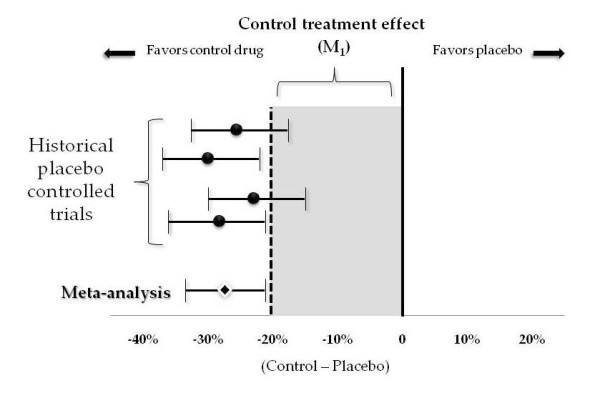
A forest plot and M1.